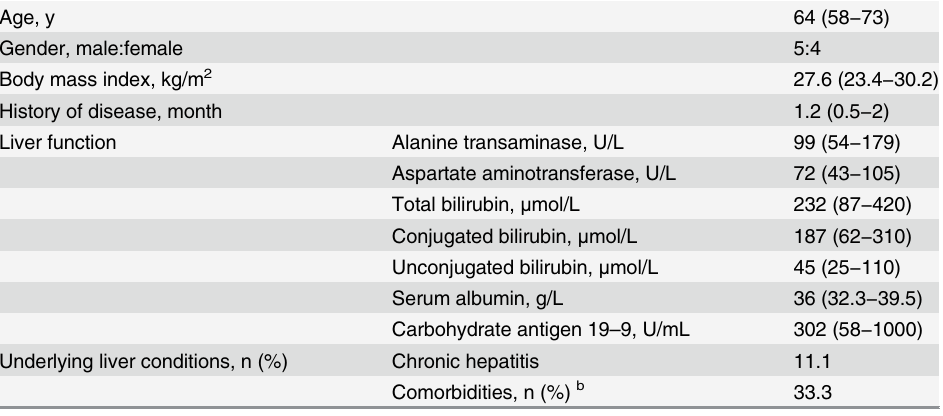
Table 1. Demographic and clinical characteristics of hilar cholangiocarcinoma patients (n = 9).